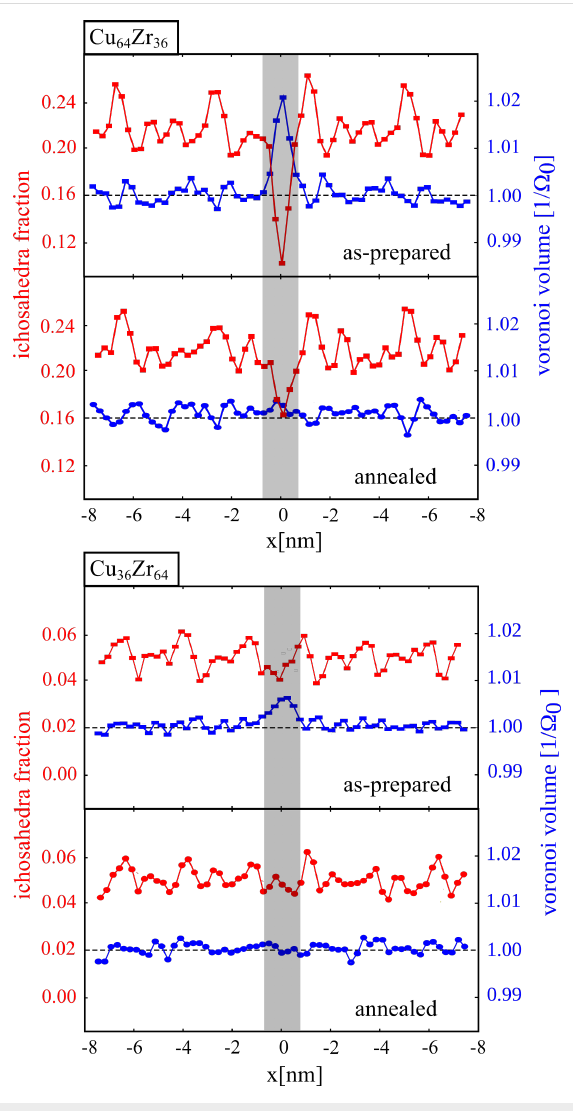
Figure 7: The fraction of Cu-centered full icosahedra and Voronoi volume in the Cu 64 Zr 36 and Cu 36 Zr 64 metallic glasses with a planar glass–glass